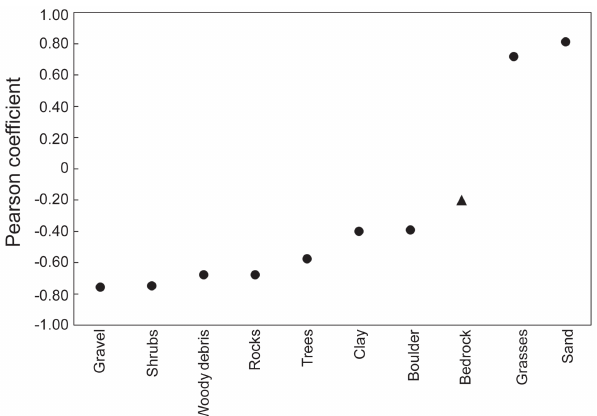
Fig. 3. Pearson correlation between the stream scores of the first RLQ axis and the original values of the environmental variables. All correlations were significant (Pearson correlation, P < 0.05), except for the proportion of bedrock in the substrate